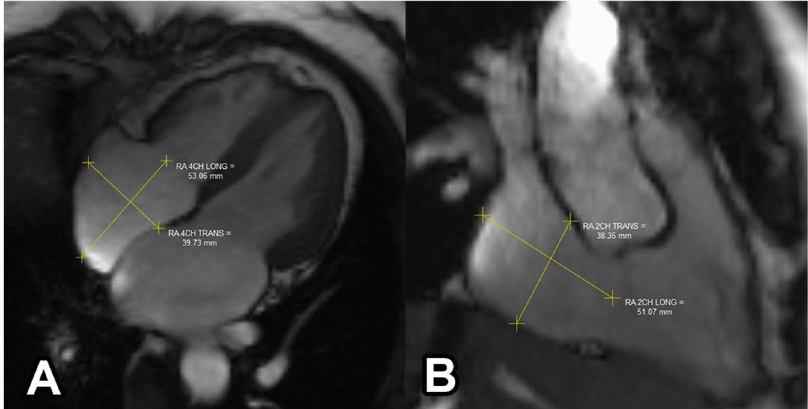
Figure 2. Measuring the right atrium dimensions in a 4-chamber view and a right ventricle (RV) 2-chamber view. ( A ) longitudinal dimension and transverse dimension in the right ventricle 2-chamber view. ( B ) longitudinal dimension and transverse dimension in the 4-chamber view. Yellow lines indicate the dimensions measured.